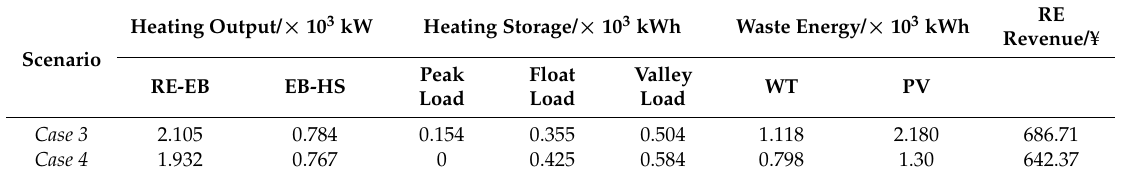
Table 3. Comparison of Case 3 and Case 4 regenerative electric (RE) scheduling results.